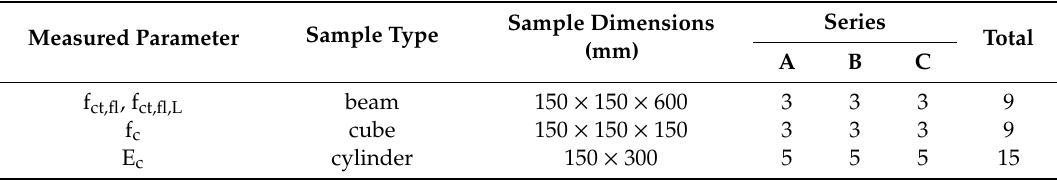
Table 1. Scope of tests and specification of